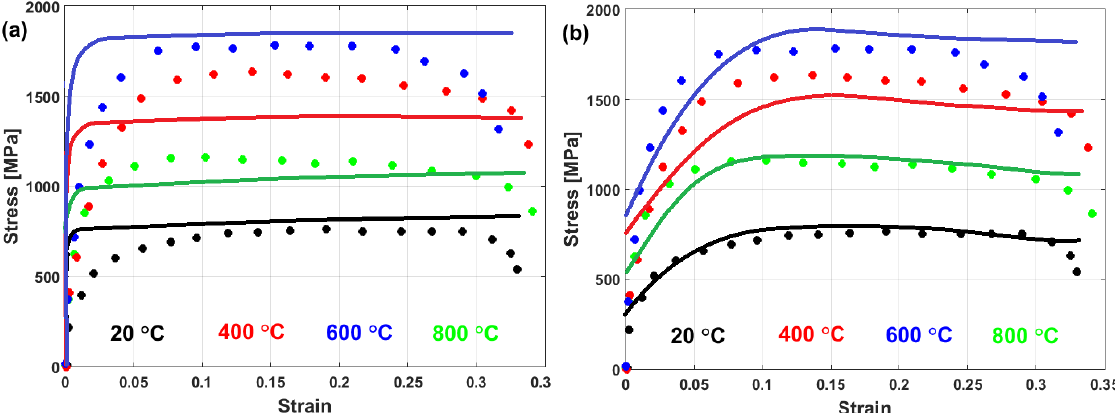
Figure 34. Comparison between experimental stresses (solid lines) and predicted stresses (solid lines) for FeCr alloy at 8000 s −1 obtained by ( a ) the original JC model and ( b ) the modified JC model that was presented by Zhao et al. [85].